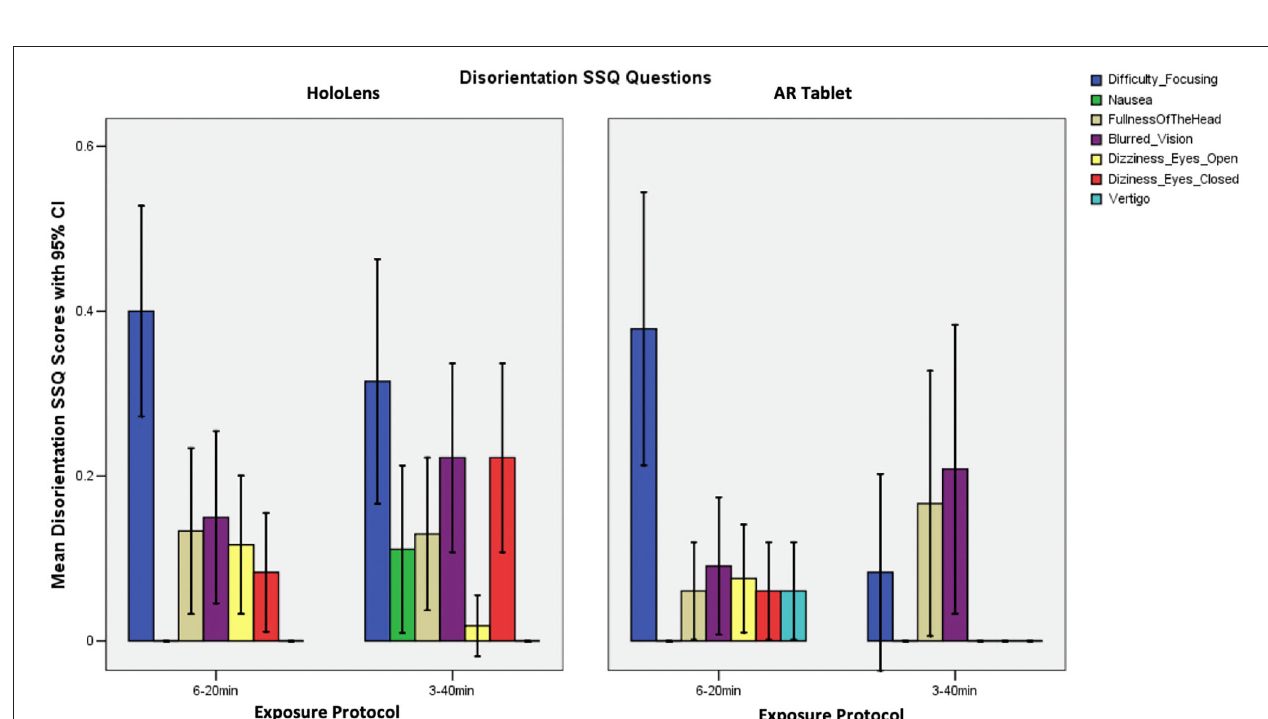
FIGURE 4 | Mean disorientation SSQ question scores with 95% CI.